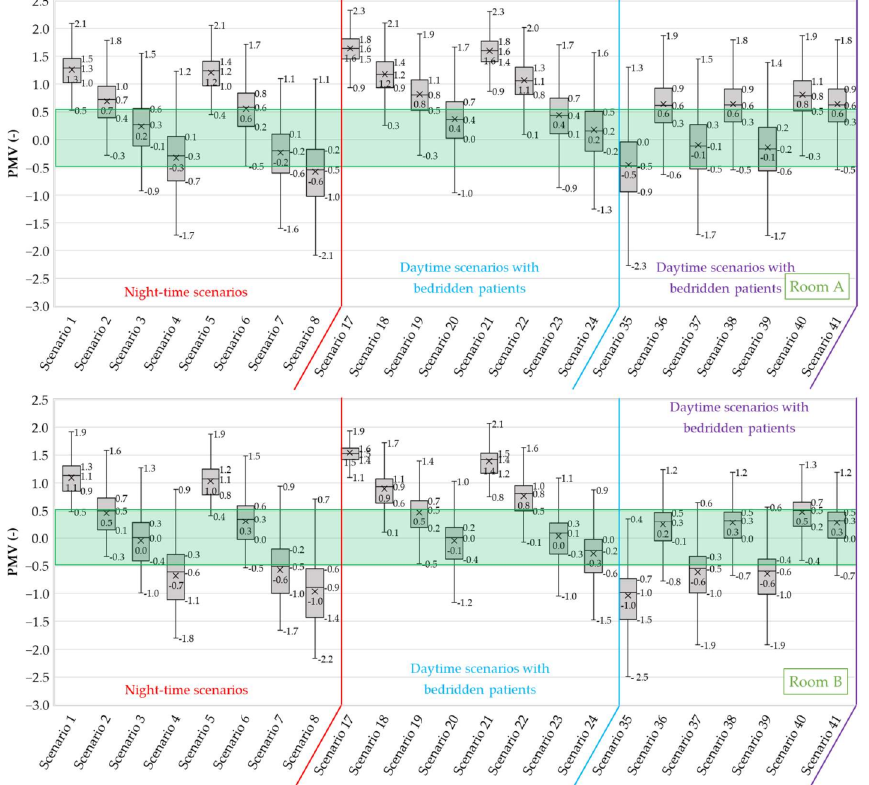
Figure 24. PMV distributions of the different scenarios in autumn